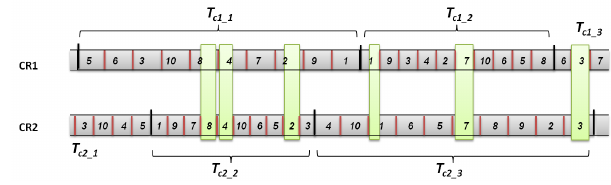
Figure 5. The random cycle duration and asynchronous operation provides overlapping between the both CRs in the free channels